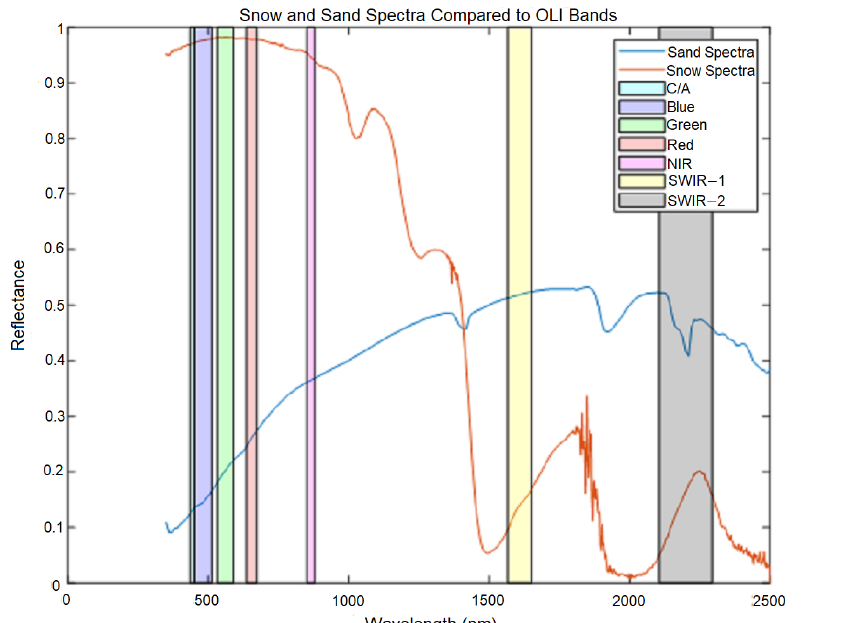
Figure 6. Snow and sand spectra over the OLI bands showing snow having a high-signal value for VNIR bands and sand having a high-signal value for SWIR bands